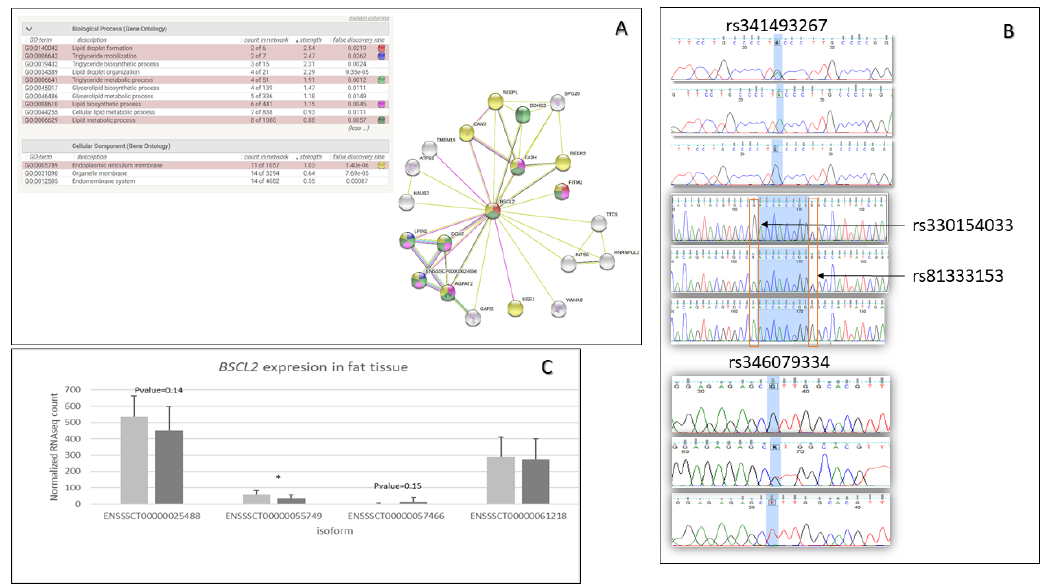
Figure 2. BSCL2 gene information about the gene function, BSCL2 isoform expression, and BSCL2 identified polymorphisms. ( A ) PPI analysis for BSCL2 gene using STRING tool. ( B ) Chromatograms present Sanger sequencing results for three missense mutations (rs341493267, rs330154033, rs81333153) and one downstream gene variant (rs346079334). The chromatograms were visualized by FinchTV vs. 1.4.0 chromatogram viewer (Geospiza, Inc.; Seattle, WA, USA; http://www.geospiza.com), accessed on 20 April 2022. ( C ) BSCL2 isoform expression dependent on fat tissue deposition based on fat RNA-seq results. Light grey — LFD group, dark grey — HFD.